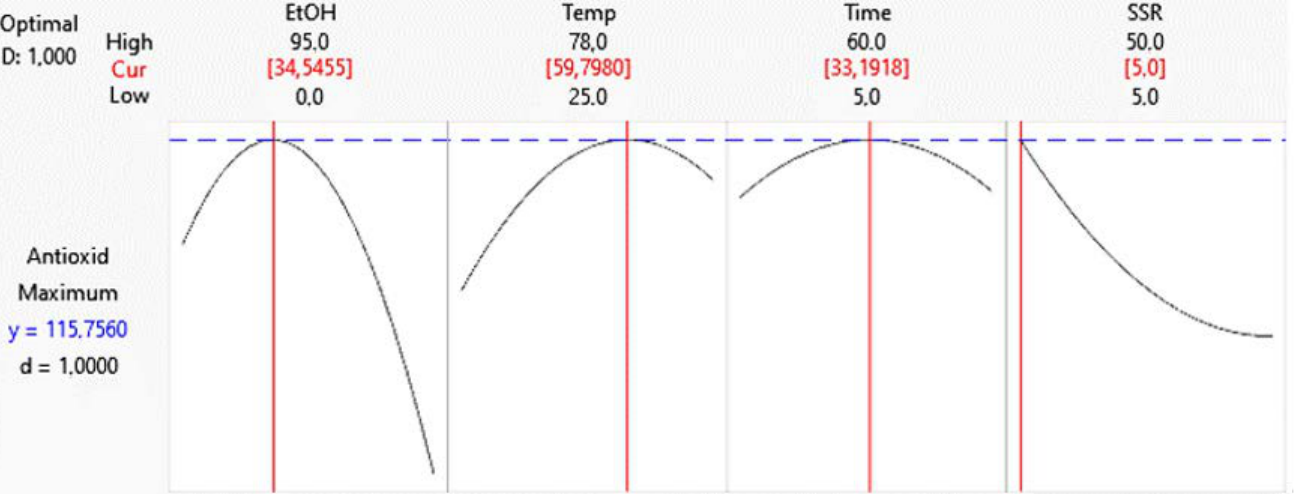
Figure 2. Total polyphenolic compounds and anthocyanins for individual extraction experiments from H. sabdariffa. Error bars represent standard deviation. Tuckey test results for the 27 experiments are shown in Supplementary Table S1 (TPC) and Supplementary Table S2 (PAC).